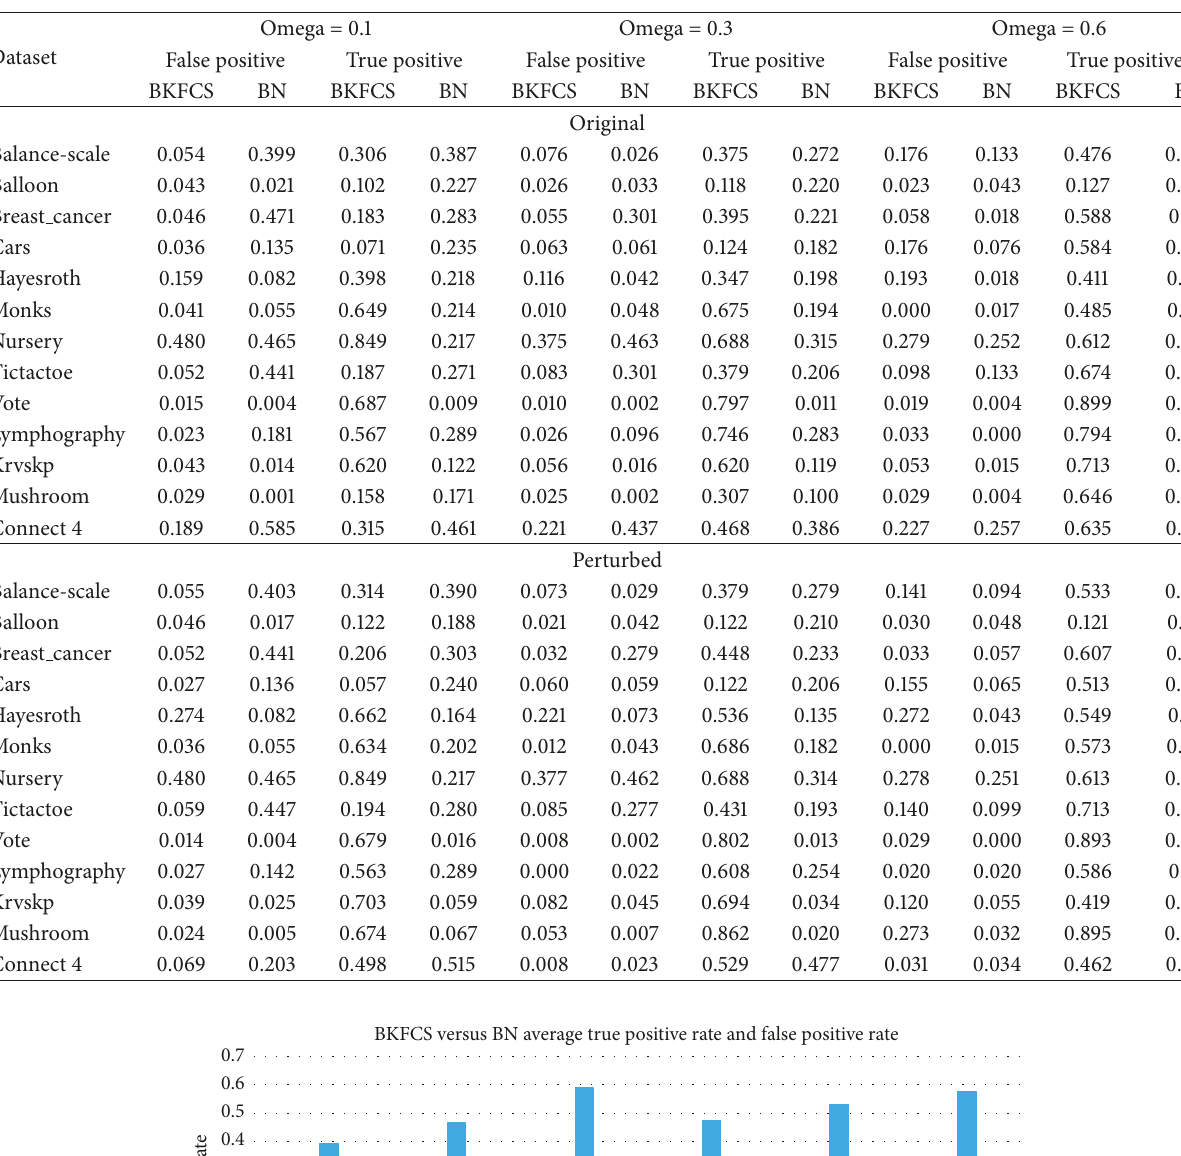
Table 11: BKFCS versus BN performance.